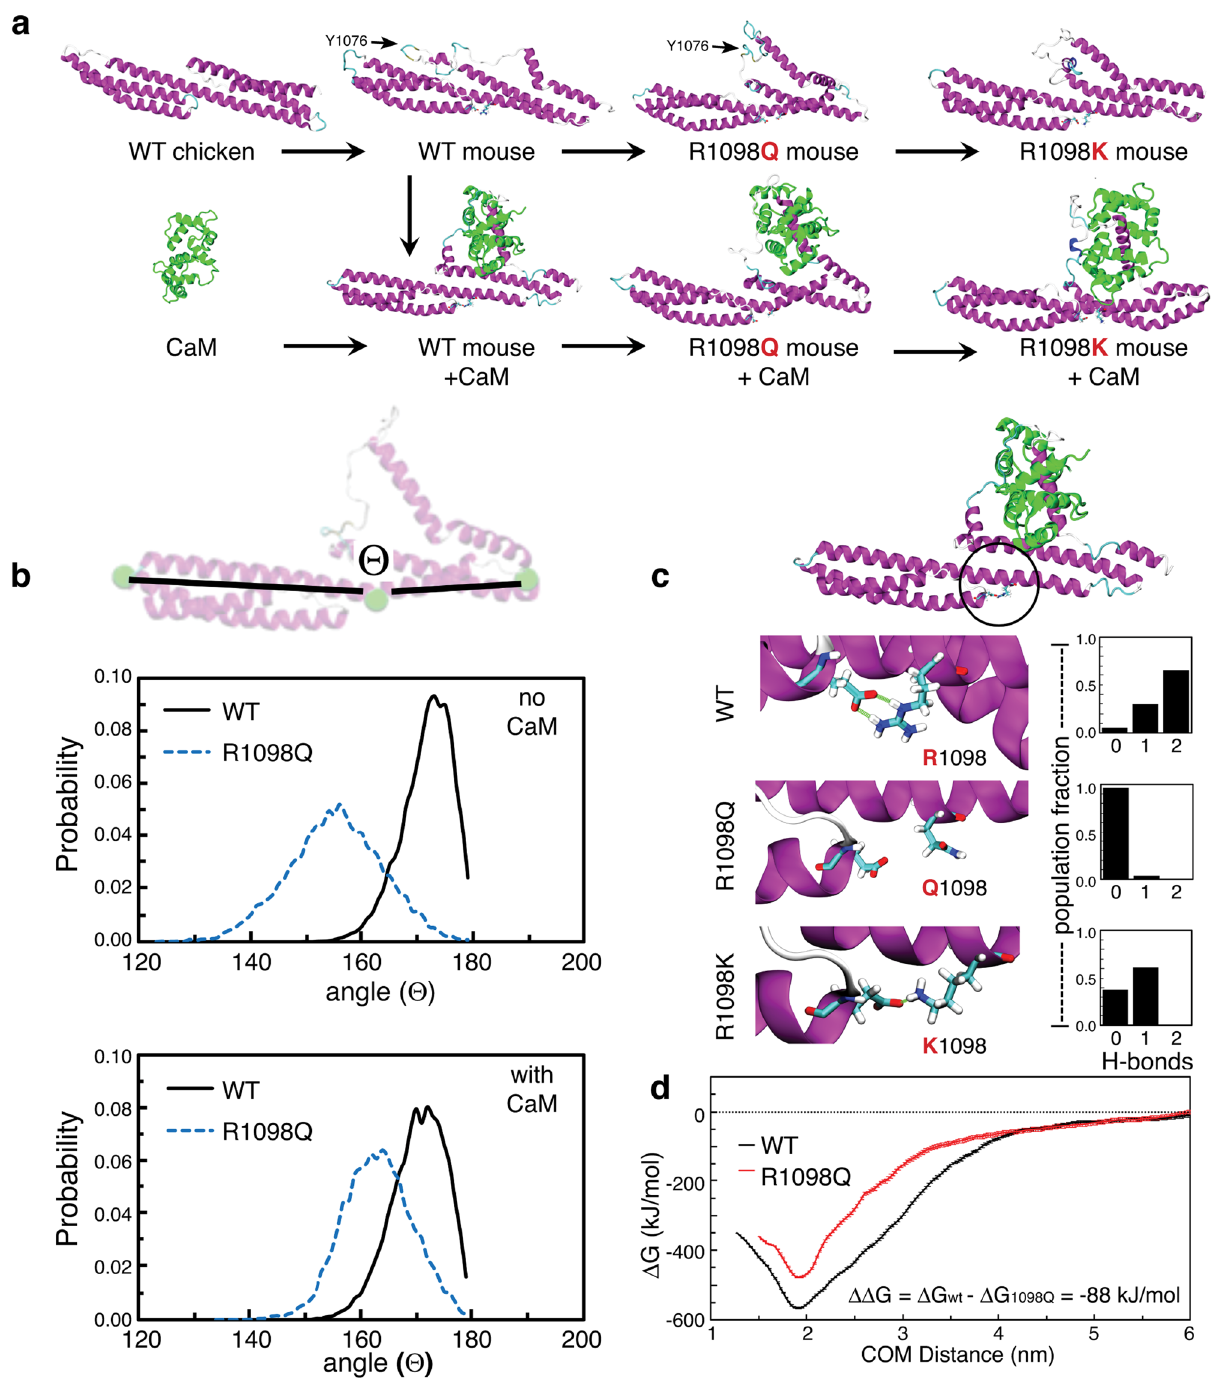
Figure 8. Molecular dynamics simulations predict enhanced flexibility of R1098Q spectrin with reduced calmodulin (CaM) binding and enhanced susceptibility to calpain cleavage. ( a ) Schematic of intermediate protein complexes simulated with molecular dynamics of spectrin repeats 9–10 with and without bound CaM. (Also see supplemental movie M2). ( b ) Convex bending of the spectrin scaffold (angle between adjacent monomers) is substantially shifted in R1098Q mutants, sampling both a more convex angle than WT spectrin and a broader distribution of values. ( c ) Hydrogen-bonding between D922 and either R1098, Q1098, or K1098 (a hypothetical variant) is markedly different between WT and variant spectrins. Salt-bridging between D922 and R1098 is strongest due to the presence of opposing charges and two hydrogen bond donors. Mutations that conserve native charge ( e.g. R1098K) could still maintain intermediate hydrogen-bonding and scaffold flexibility, while pathological mutations such as R1098Q fully abrogate hydrogen-bonding and enhance spectrin flexibility. ( d ) The free energy of binding between CaM and spectrin is reduced by 88 kJ/mol in the R1098Q mutant, equivalent to a predicted 15% loss in binding affinity compared to WT